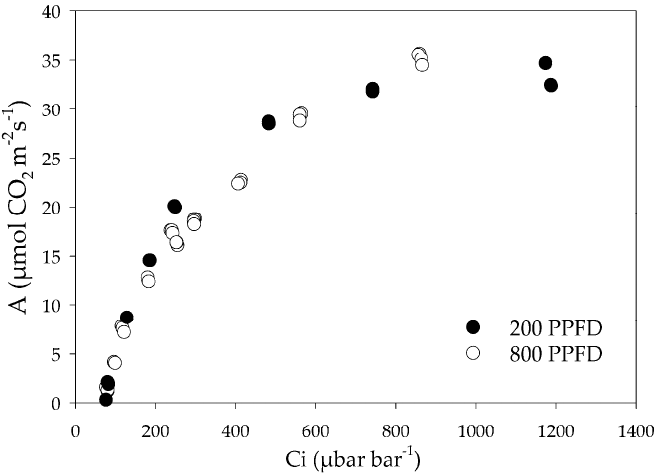
Figure 1. Relation between CO 2 assimilation and intercellular CO 2 concentration (Ci) in leaves of spinach grown in a growth chamber under 800 µ mol m − 2 s − 1 (800 PPFD) and 200 µ mol m − 2 s − 1 (200 PPFD) white light